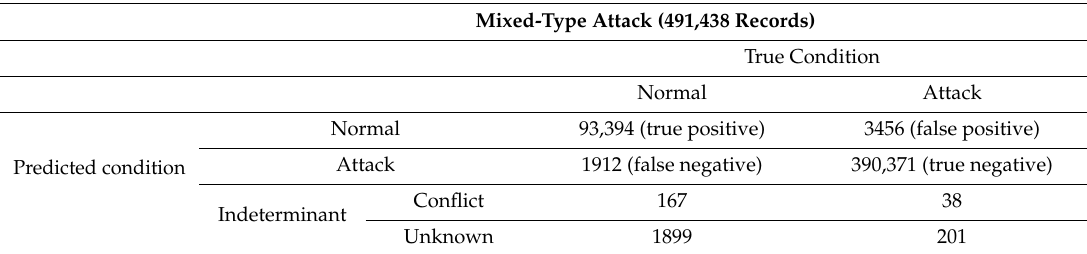
Table 9. Detection performance for mixed-type